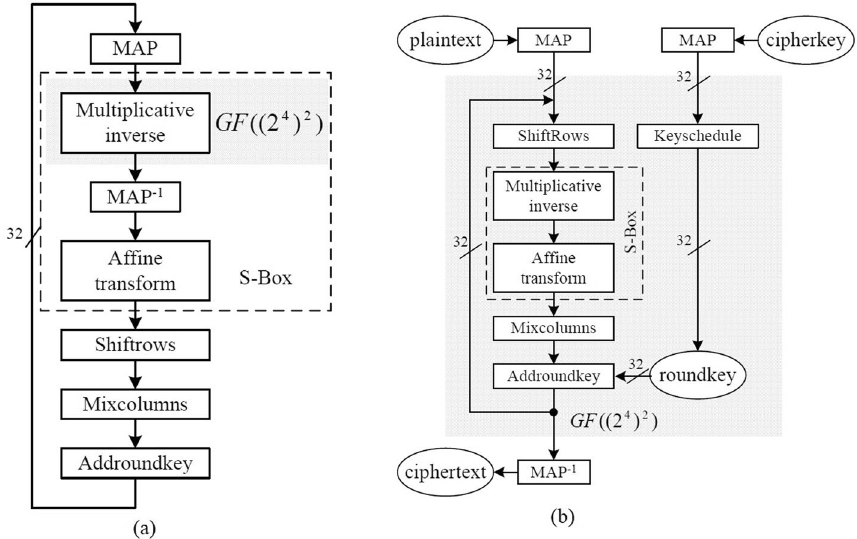
Fig. 4 a Partial in composite field b Complete in composite